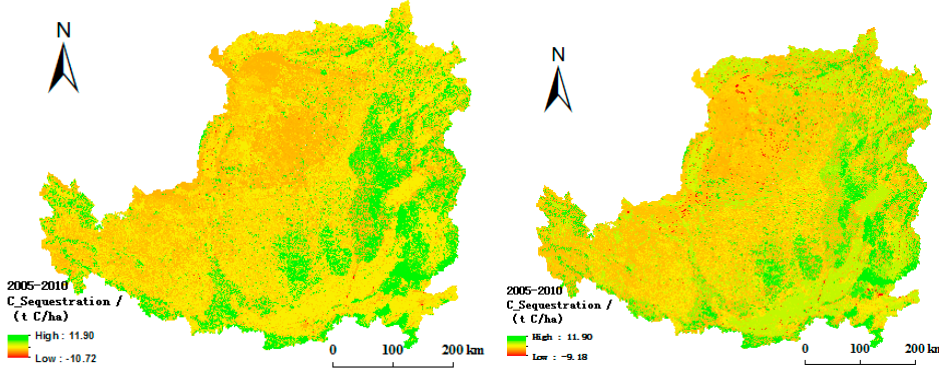
Figure 3. Temporal and spatial patterns of carbon storage in Loess Plateau from 2000 to 2010.